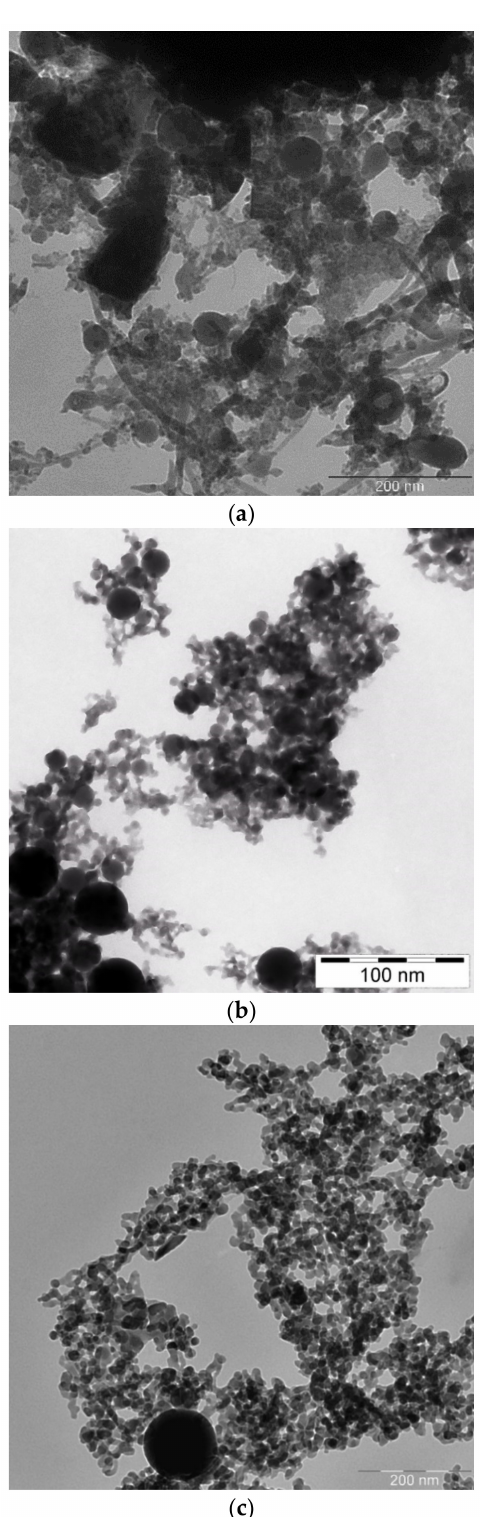
Figure 1. TEM view of nanoparticles (NPs) of barium titanate BaTiO 3 (BTO) generated by ablation in H 2 O at pulse duration of 1 ps ( a ), in H 2 O at pulse duration of 200 ns ( b ), and ablation in H 2 O 2 at pulse duration of 200 ns ( c ). Scale bars denote 200 ( a , c ) and 100 nm ( b ). The size distributions of BTO NPs generated by laser ablation in di ff erent liquids and various pulse durations are shown in Figure